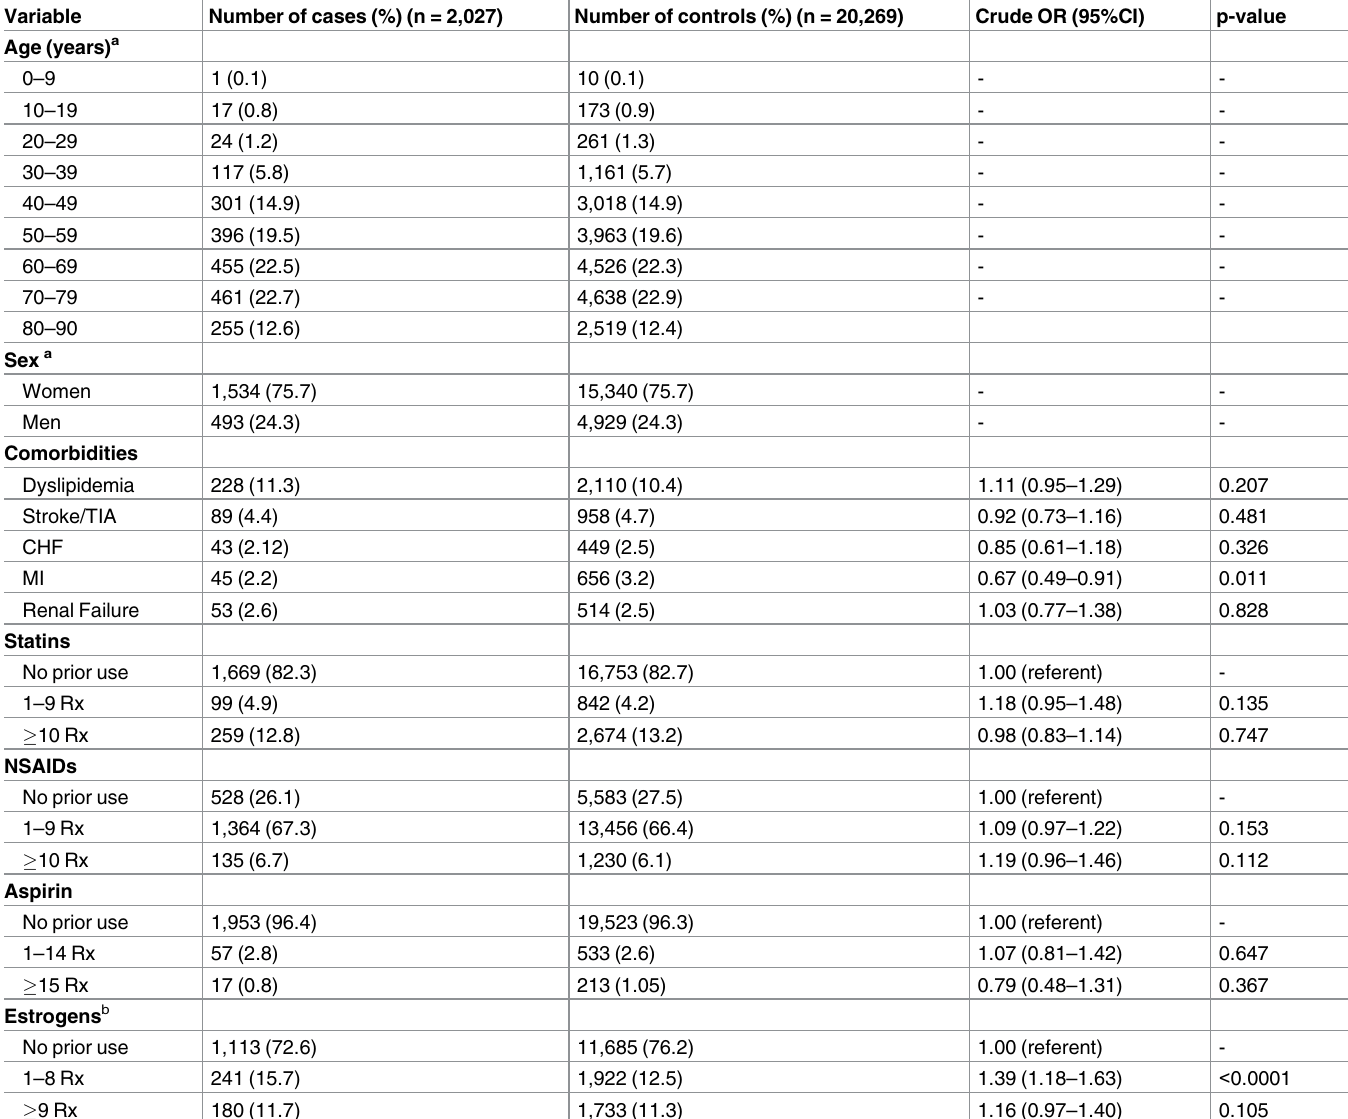
Table 1. Characteristics of meningioma cases and